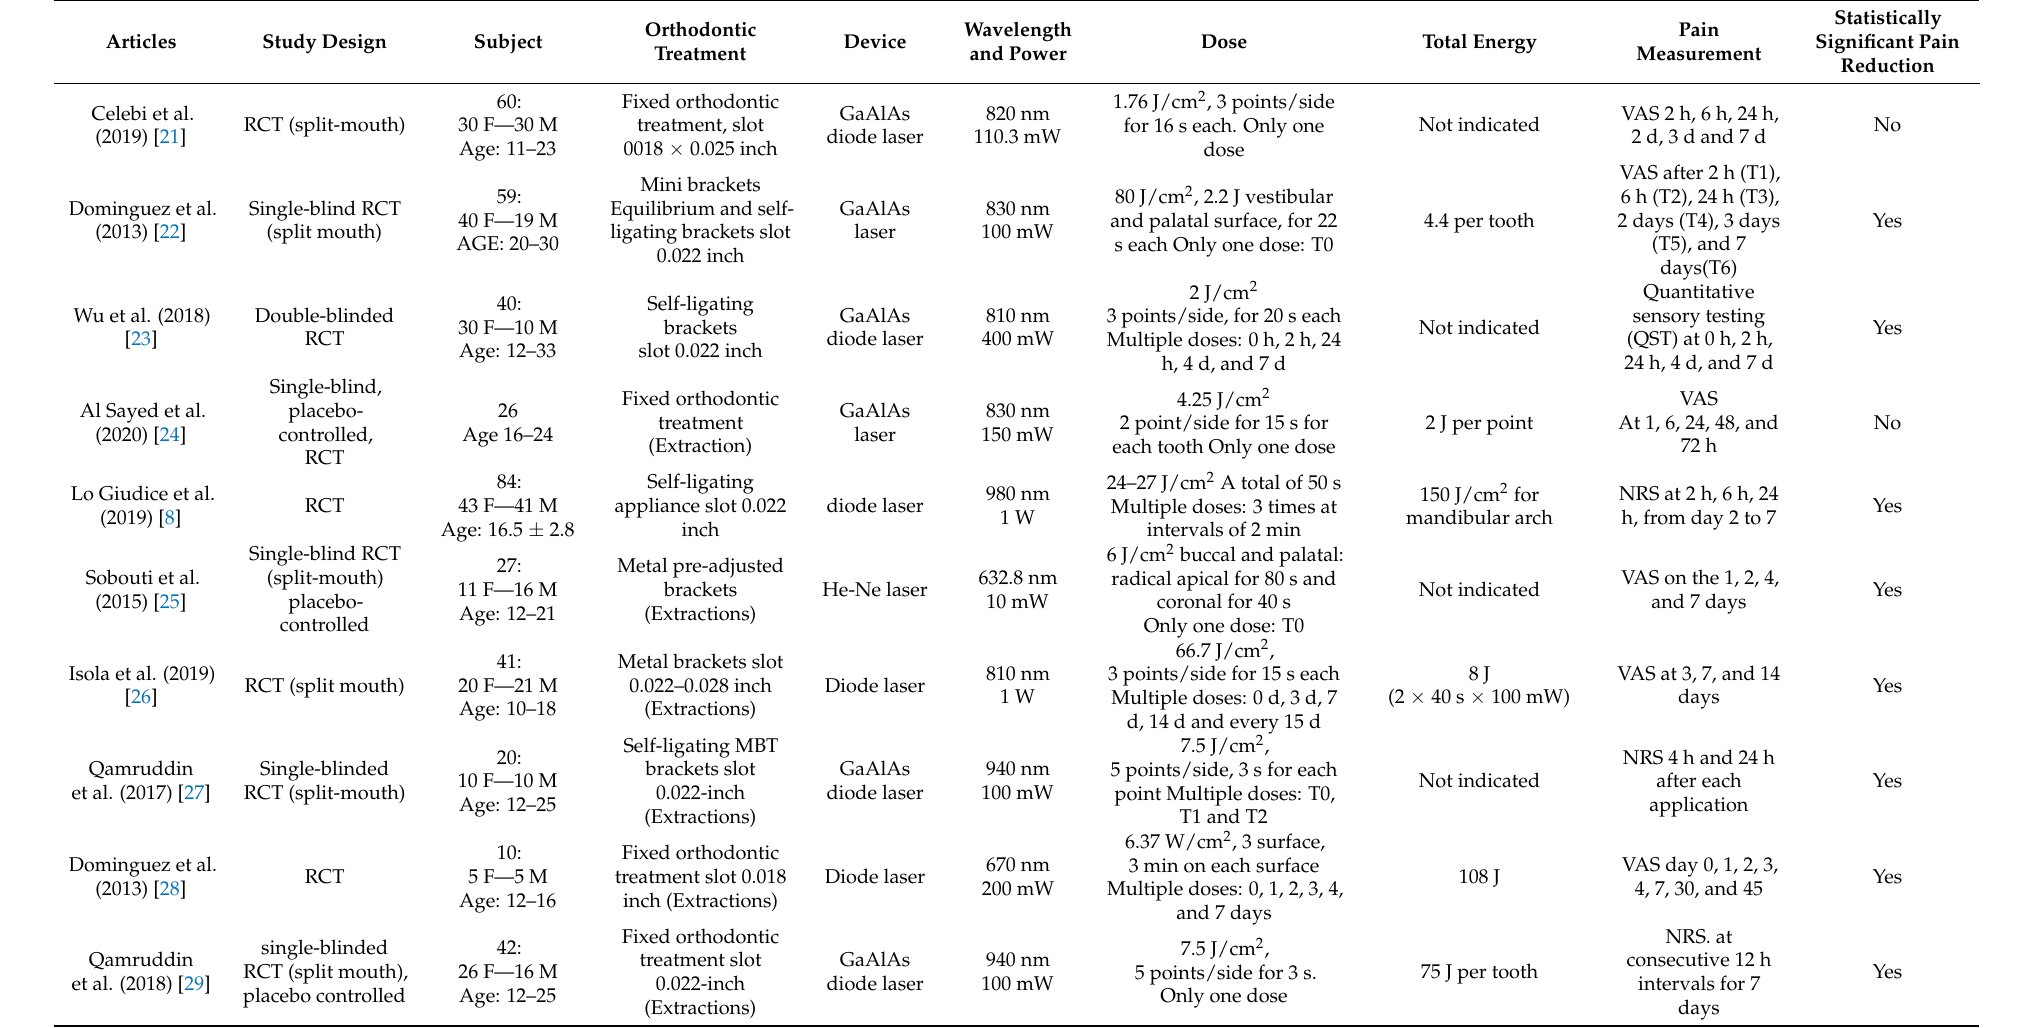
Table 1. The different parameters of each